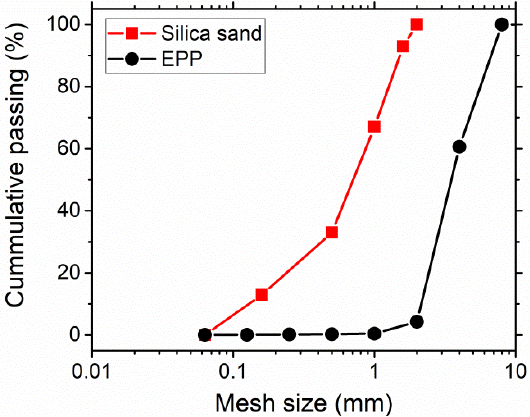
Figure 4. Grain-size curves of used mixed silica sand and EPP aggregates. The mesh size is presented on a logarithmic scale.